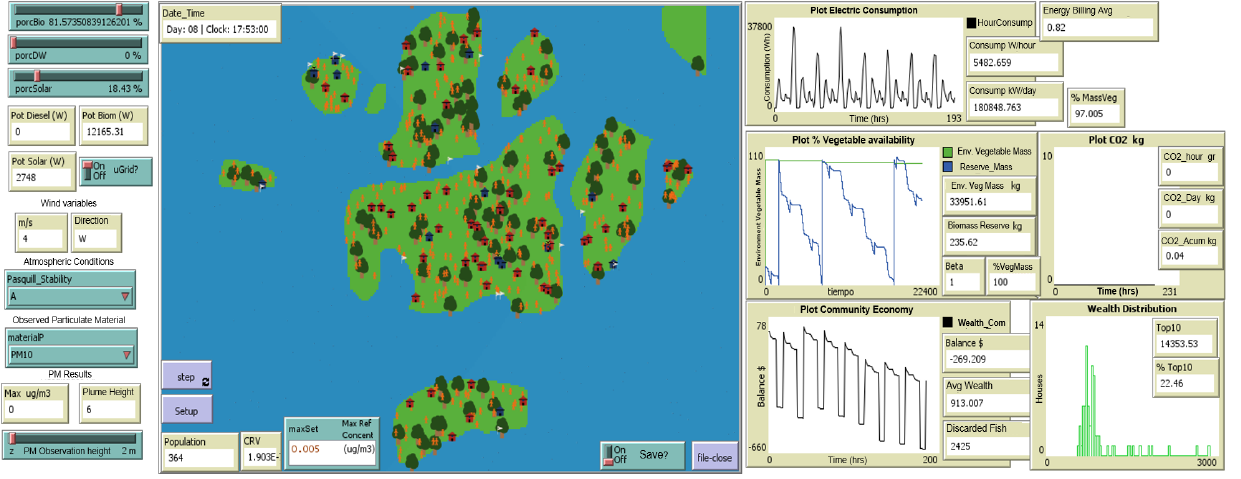
Figure 15. Interface of the socio-technological simulation model implemented in Netlogo.